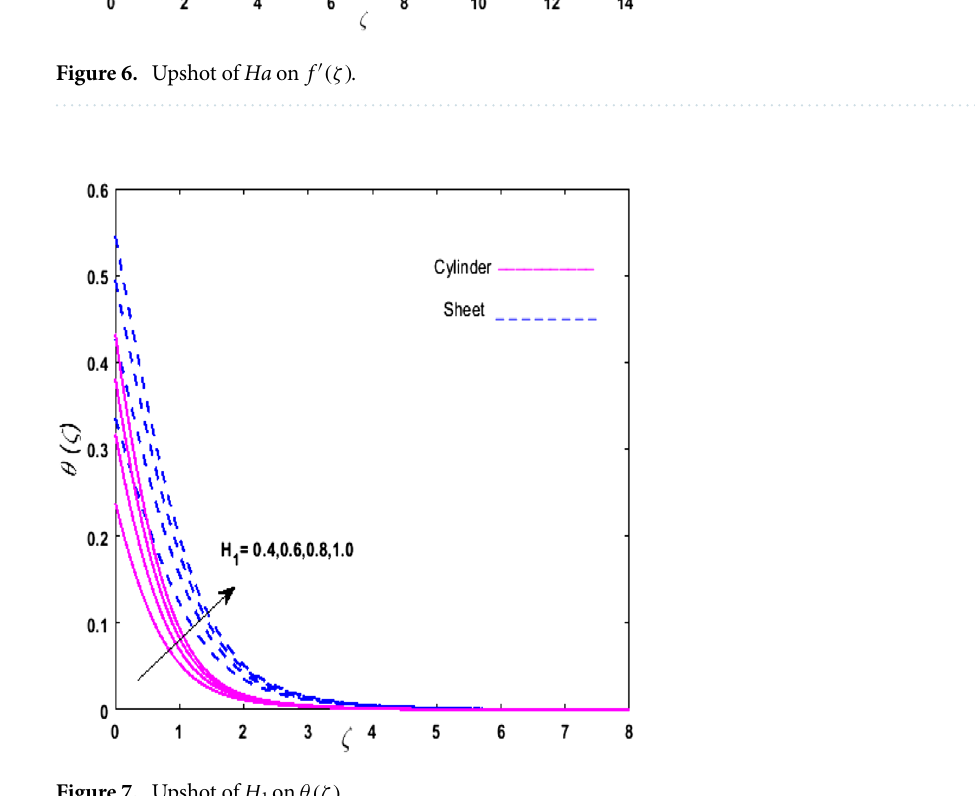
Figure 7. Upshot of H 1 on θ(ζ)